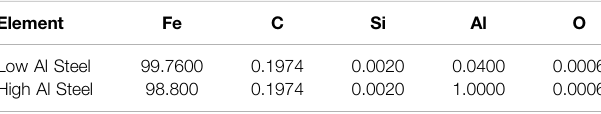
TABLE 1 | Composition of iron alloys measured using Spark OES, all wt%. Element Fe Low Al Steel